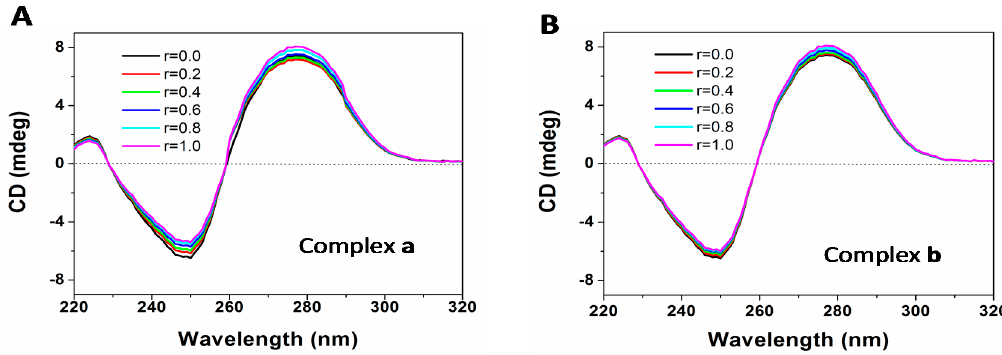
Figure 8. CD spectra of CT-DNA in the presence of increasing concentration of complex a ( A ) and b ( B ) with the concentration ratio (r) of platinum complex to DNA of 0, 0.2, 0.4, 0.6, 0.8, and 1.0, respectively.